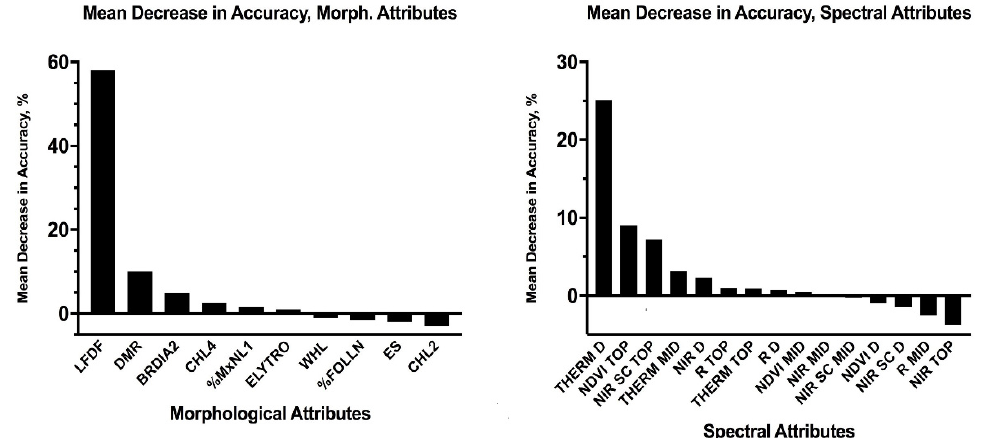
Figure 5. Mean decrease accuracy (MDA) for morphological ( left ) and spectral ( right ) traits using random forest. Acronyms as in Appendix B, except “D” replaces “ ∆ “ here.